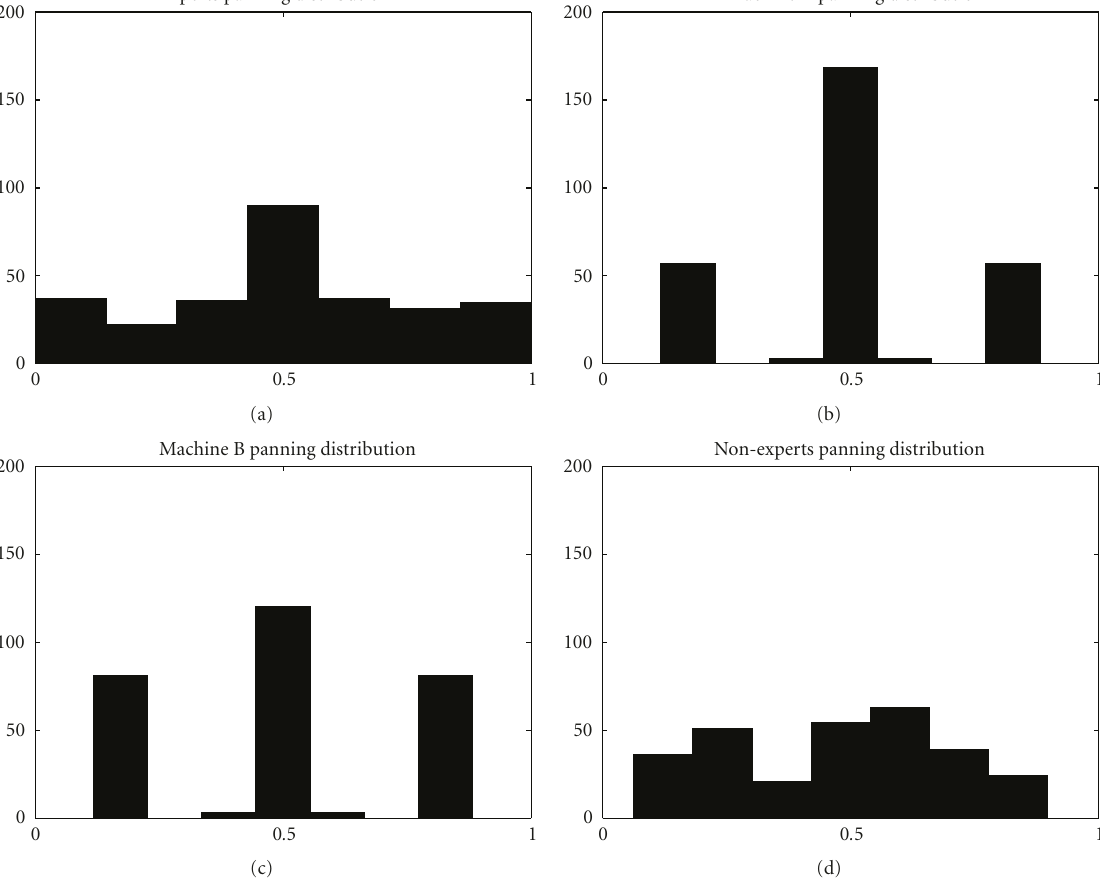
Figure 10: Panning space distribution histograms ( P W = 0 .